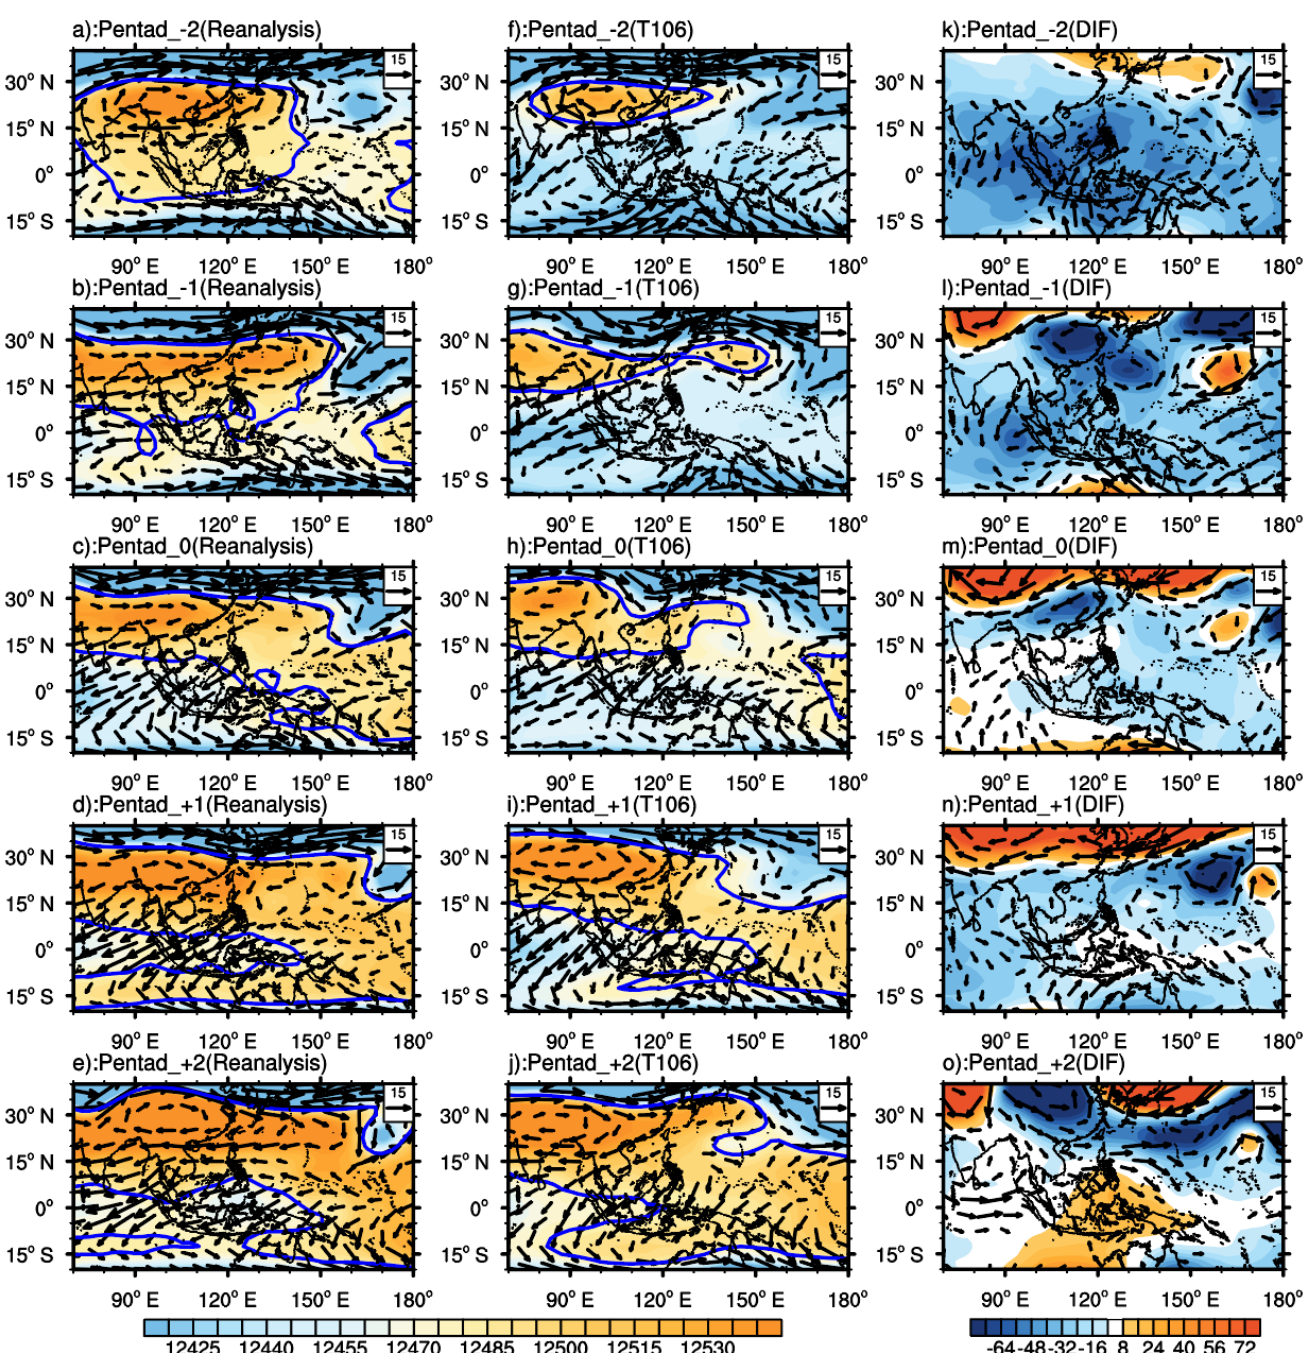
Figure 11. Same as Figure 9, but for 200 hPa. The blue contour of 12,480 gpm denotes SAH. ( a − e ): reanalysis; ( f − j ): prediction; ( k − o ): difference between predictions and reanalysis.